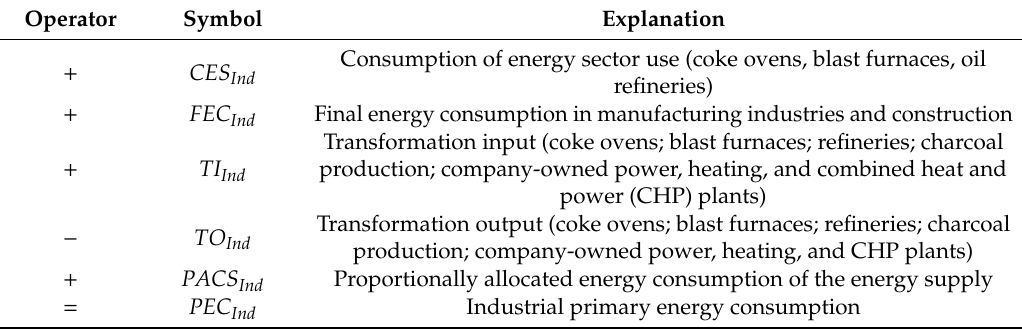
Table 5. Determination of the primary energy consumption for sector s = Industry, based on Equation